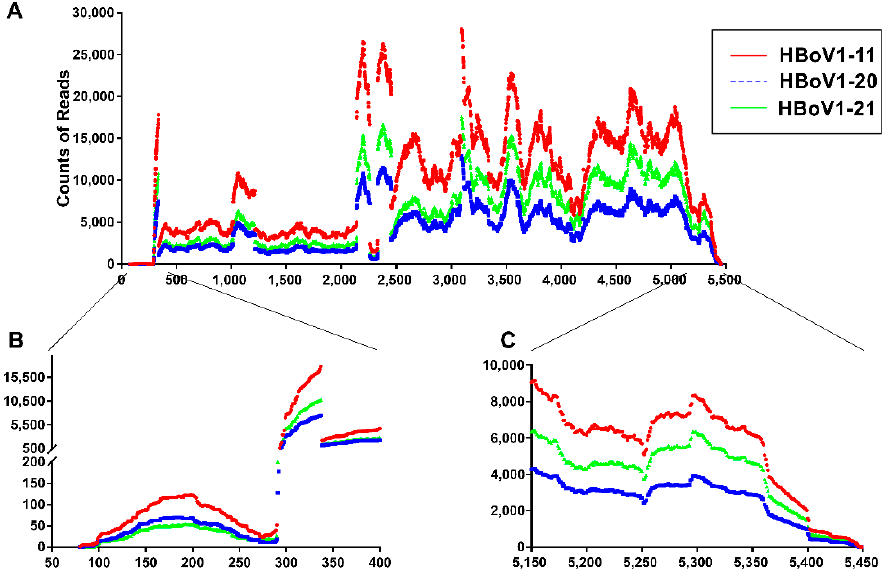
Figure 2. Coverage plots of viral mRNA-seq reads mapped to the HBoV1 genome. Red, blue and green lines represent three RNA samples of HBoV1-infected HAE-ALI cultures. ( A ) Reads mapped to HBoV1 full-length genome. The reads mapped to HBoV1 full-length genome are shown with the coverage across the entire HBoV1 genome (GenBank accession no: JQ923422). ( B and C ) Read coverages of the left- and right-hand ends. The read coverages of the left (nt 50–400) ( B ) and right (nt 5150–5450) ( C ) ends of the viral genome are enlarged for details.